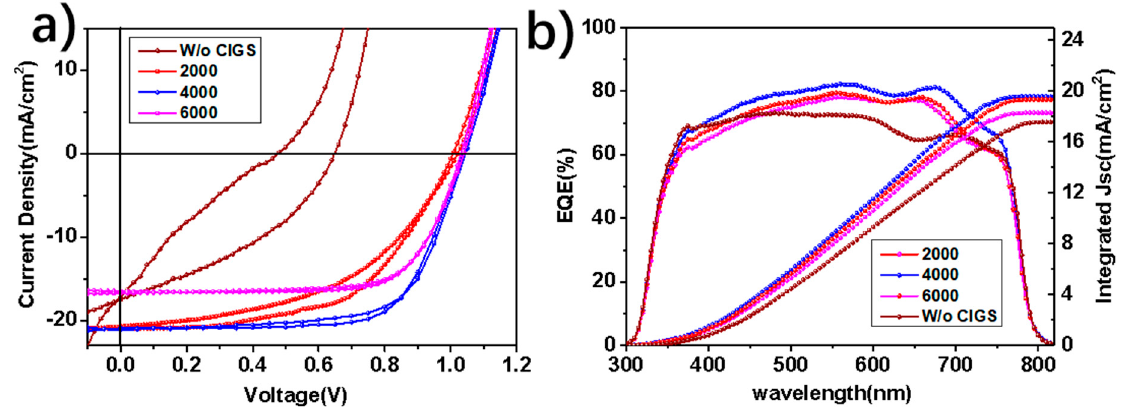
Figure 2. ( a ) J-V curves of PSCs with and without CIGS HTL layer, the active area of the devices is cm 2 . ( b ) EQE spectra of the PSCs. The J sc were integrated from each EQE 0.1 cm 2 . ( b ) EQE spectra of the PSCs. The J sc were integrated from each EQE curve.